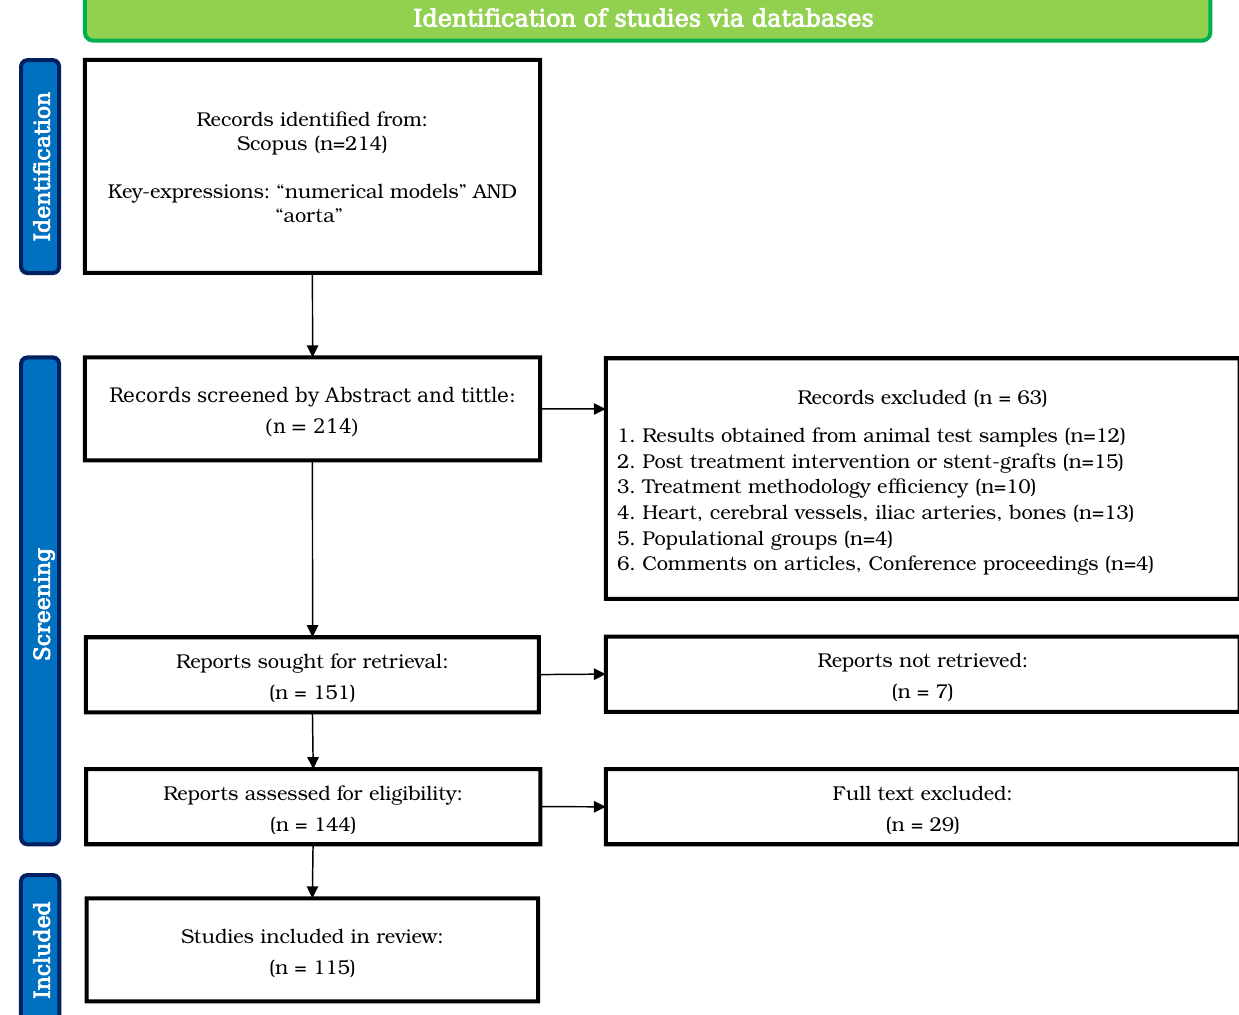
Figure 1. PRISMA flow chart of the systematic search strategy.